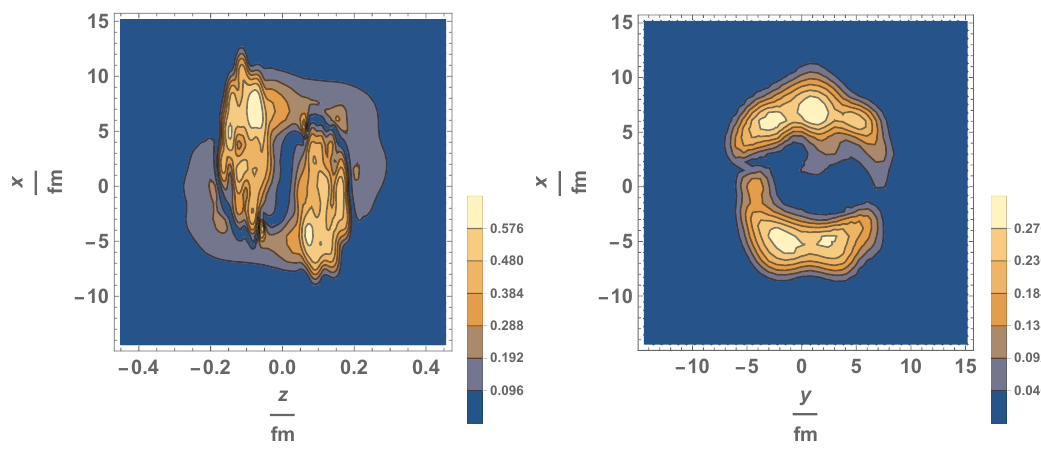
Figure 5 . The absolute value of the fluid three velocity | u /u 0 | at time t = 0 . 1 fm/ c . The left plot shows | u /u 0 | at a y = 0 slice, the right plot shows it at a z = 0 slice.